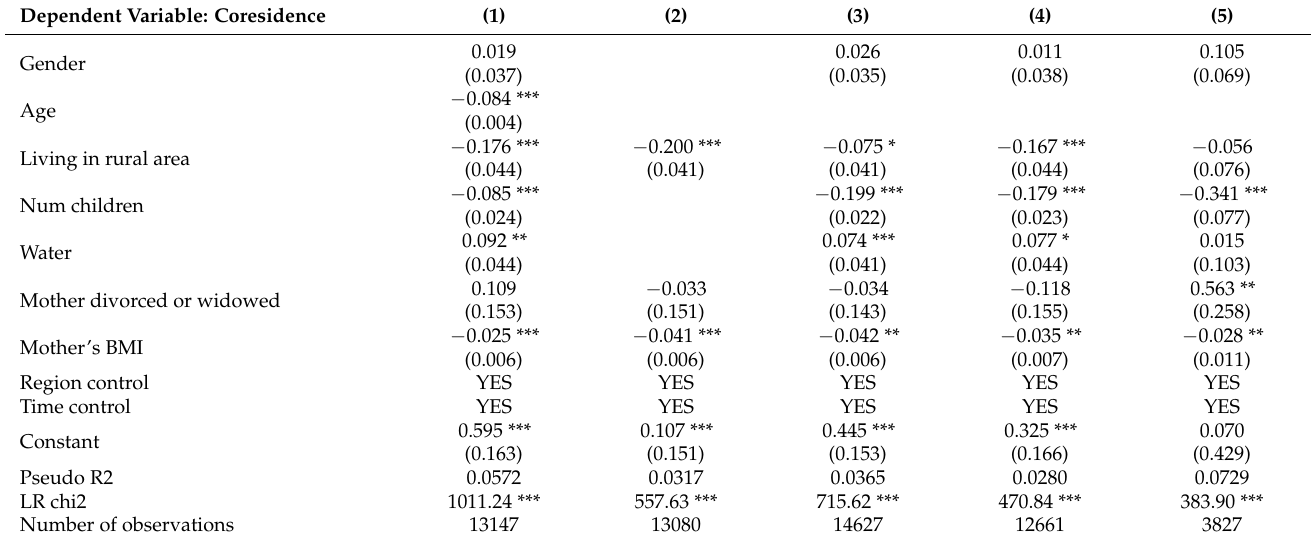
Table 3. Logit models with